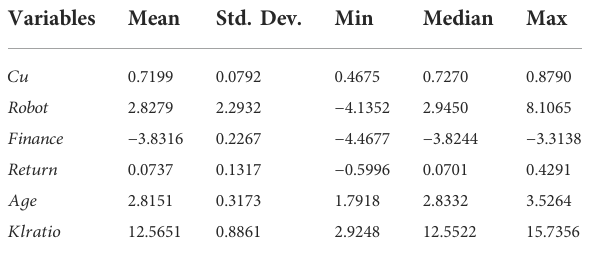
TABLE 4 Results of the benchmark